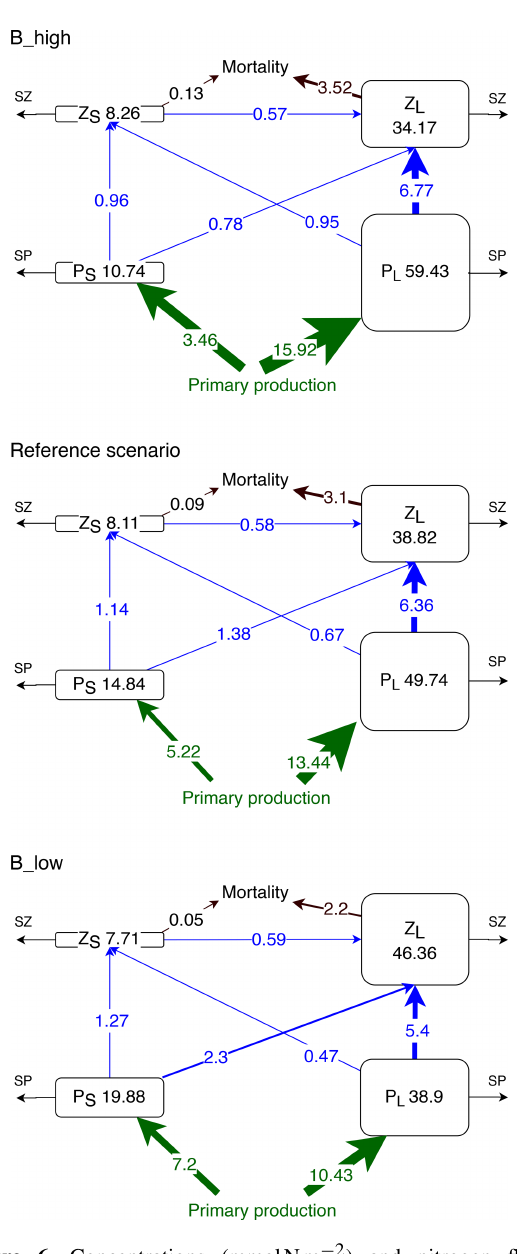
Figure 6. Concentrations (mmolNm − 2 ) and nitrogen fluxes (mmolNm − 2 d − 1 ) between plankton compartments (small and large phytoplankton P S and P L and small and large zooplankton Z S and Z L , respectively) integrated over the upper 100m or up to the seafloor if shallower than 100m and averaged over latitude and longitude in the coastal upwelling region (see Fig. 1). SZ and SP in- dicate the sinks which include phytoplankton mortality, zooplank- ton metabolism, large phytoplankton sedimentation, unassimilated primary production and unassimilated grazing (Gutknecht et al., 2013a).